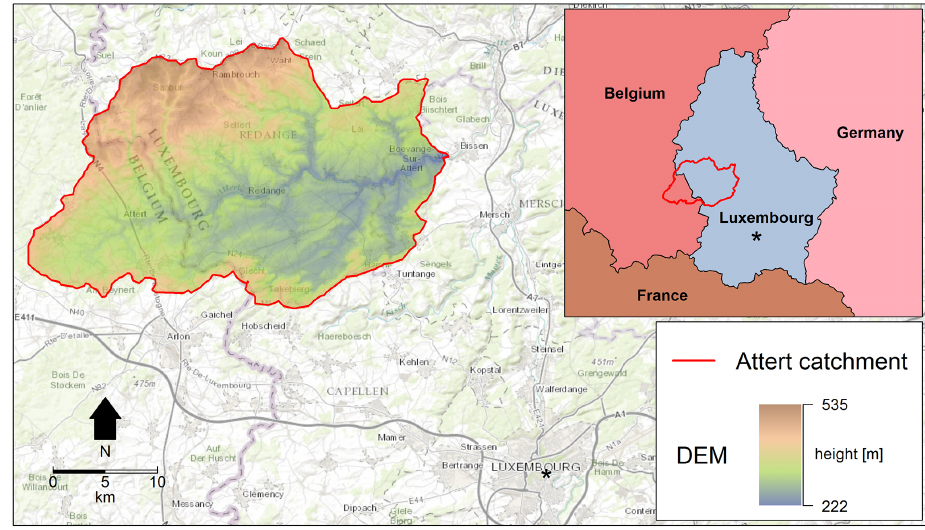
Figure 1. The location of the Attert catchment and its elevation. Catchment boundaries are given for the Bissen gauge, Luxembourg.